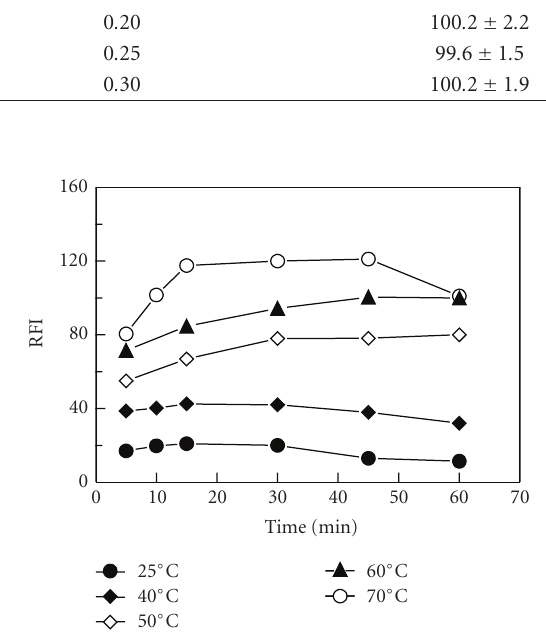
Figure 6: E ff ect of time on the reaction of FLX (0.02 μ gmL − 1 ) with NBD-Cl (0.2%, w/v) at di ff erent temperatures. RFI is the relative fluorescence